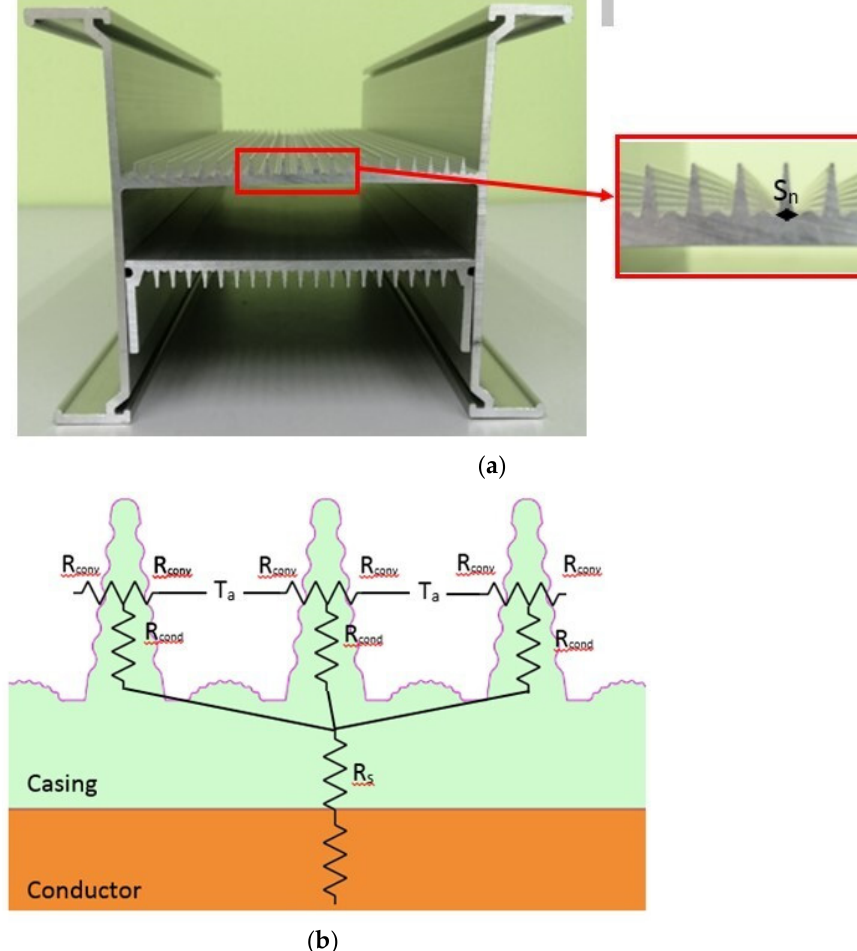
Figure 8. ( a ) Fin thickness of bus duct conductor casing heat sink ( b ) Thermal resistance network .